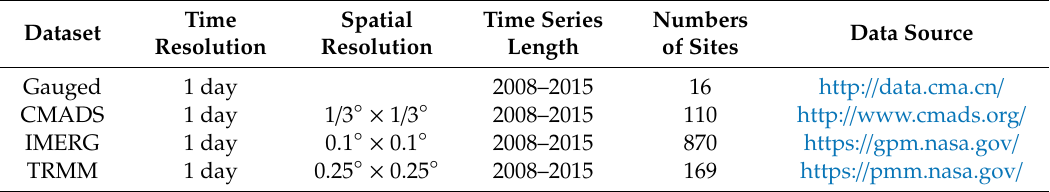
Table 1. Basic information of Gauged, CMADS (China Meteorological Assimilation Driving Datasets for the Soil and Water Assessment Tool (SWAT) mode), IMERG (Integrated Multi-satellite Retrievals for GPM) and TRMM (Tropical Rainfall Measurement Mission) used in this